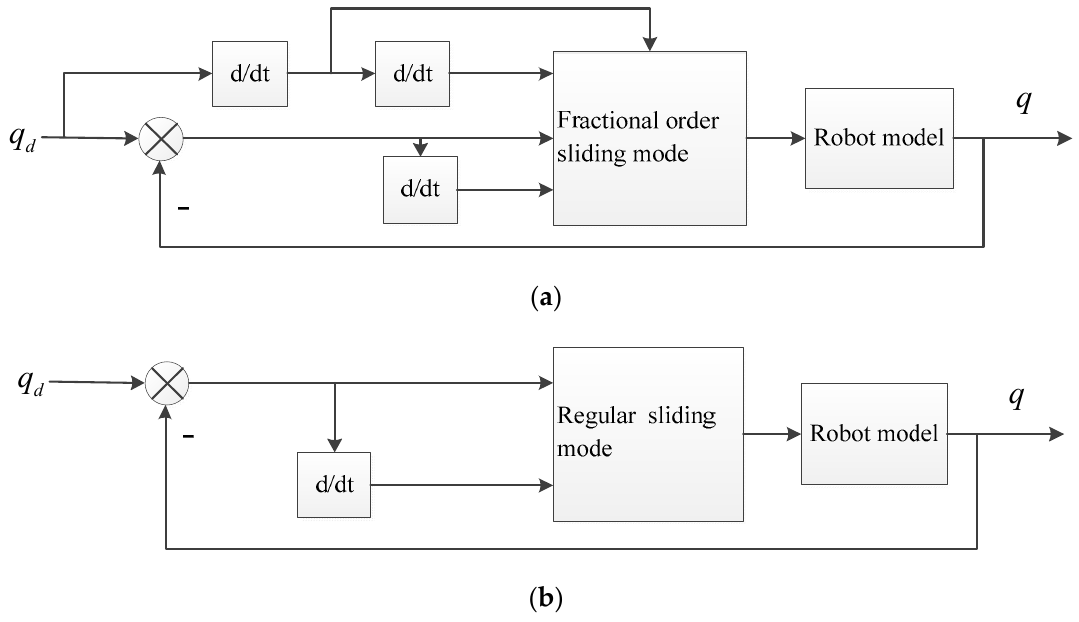
Figure 2. Sliding mode control block diagram. ( a ) FSMC control block. ( b ) SMC control block.